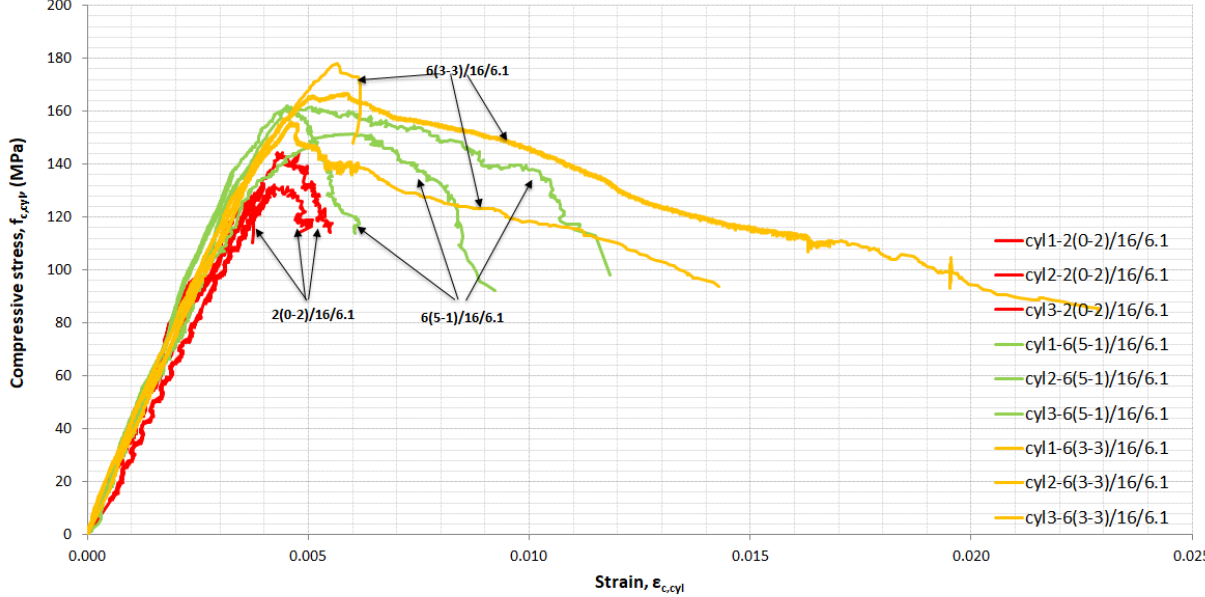
2% 6-mm-long fibres’ contribution to compressive strength is low and equal to 5.5% for cylindrical specimens. Figure 10. Stress–strain curves in compression for UHPFRC 2(0-2): The influence of w/b .